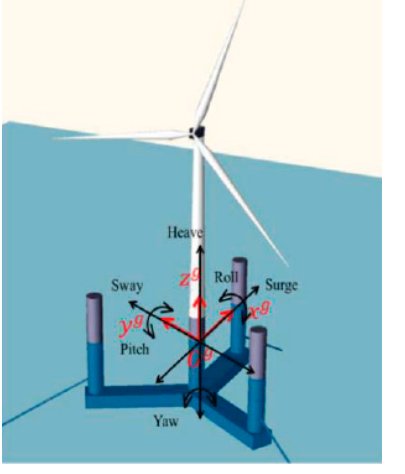
Figure 5. Layout of the FOWT.